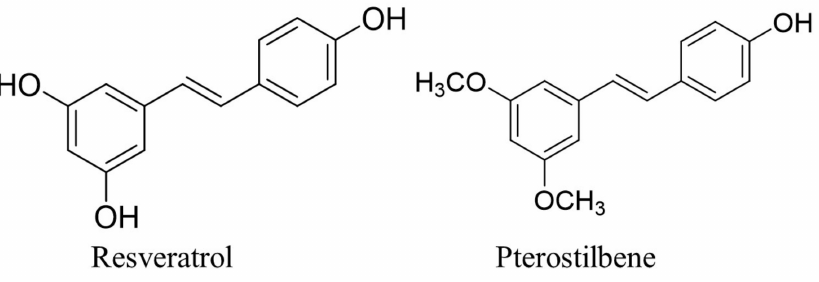
Figure 1. The chemical structure of resveratrol and pterostilbene